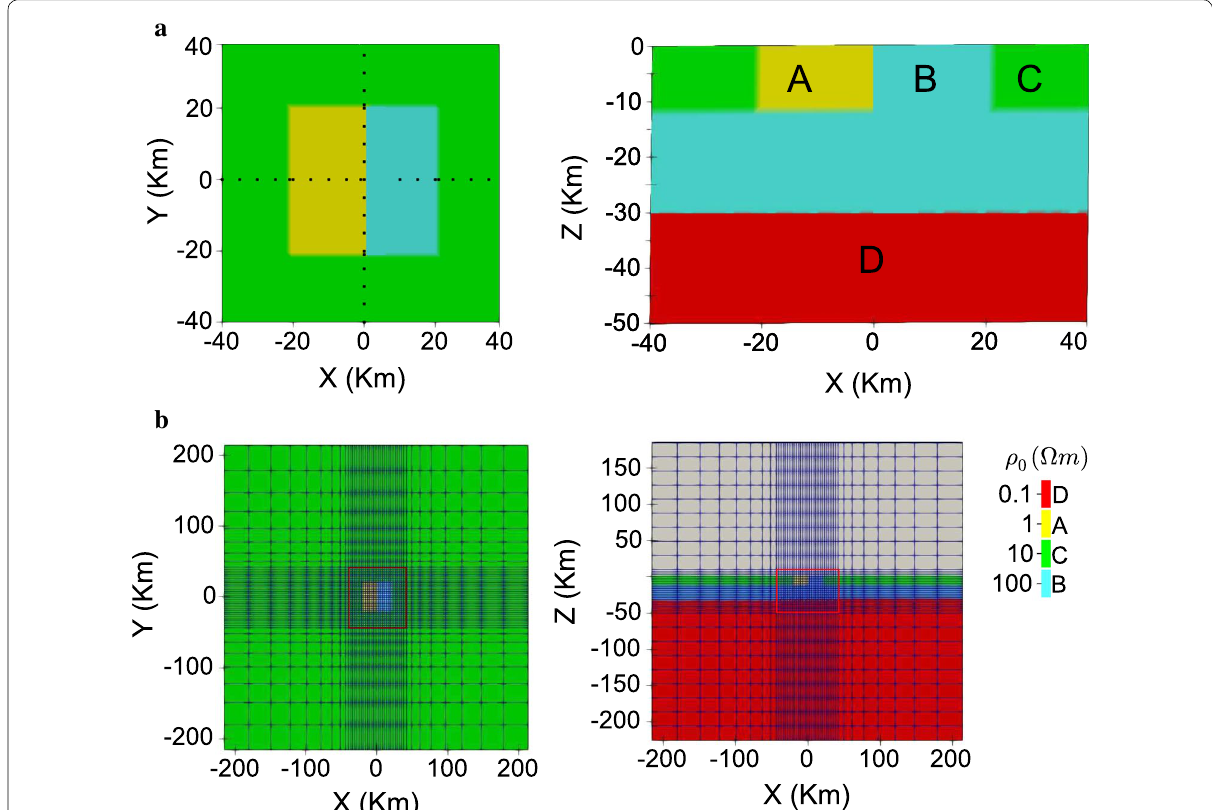
Fig. 9 Input model of COMMEMI 3D‑2. a Two adjacent rectangular blocks (A, B) with dimensions of 20 × 40 × 10 km 3 are embedded in a horizontally layered background and located at the center of the top layer. Resistivities are A = 1 (cid:31) m , B = 100 (cid:31) m , C = 10 (cid:31) m , and D = 0.1 (cid:31) m . Thickness of the first two layers is 10 km and 20 km from top to bottom. This model has overall dimensions of x , y ∈ [− 40,40 ] km, and z ∈ [ 0, − 50 ] km. Horizontal (left) and vertical (right) cross‑sections. b Computational domain, including grid structure, air layer, and boundary extension zones. Horizontal (left) and vertical (right) cross‑sections. Air height is set to 10 km, the spacing is d x = d y = d z = 3 km. The inner domain was extended 175.5 km in all directions, and the computational grid dimensions are x , y ∈ [− 215.5,213.5 ] km and z ∈ [− 205.5,205.5 ] km